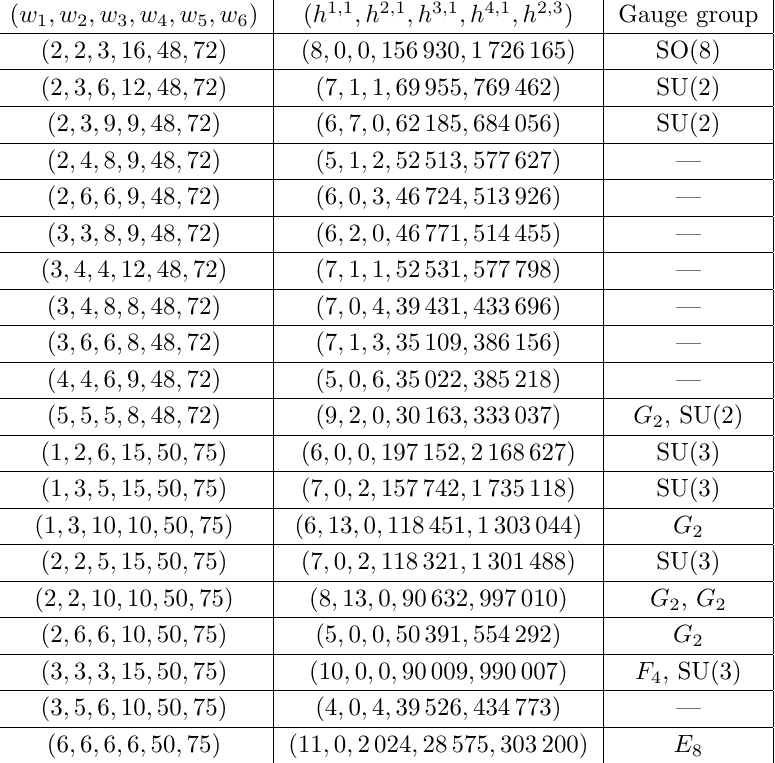
Table 12 . A list of elliptic CY5 hypersurfaces in weighted projective spaces P 1 ,w 1 ,w 2 ,w 3 ,w 4 ,w 5 ,w 6